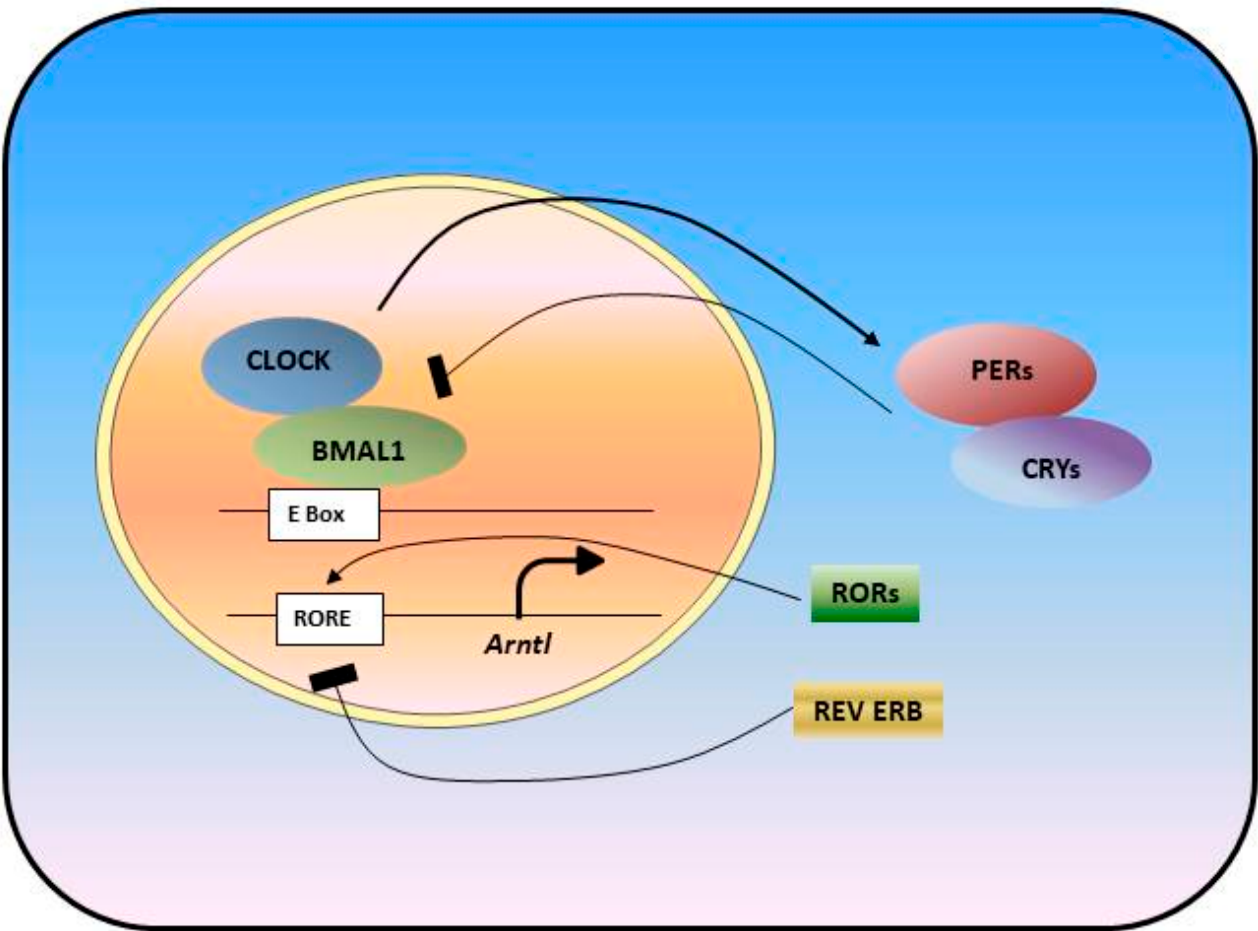
Figure 1. Molecular Circadian Oscillator is formed as a transcriptional translational feedback loop. Transcription factors, BMAL1 and CLOCK, drive the transcription of clock genes: Pers, Crys, Rev-Erbs, Rors. PER and CRY proteins, in turn, heterodimerize and inhibit CLOCK/BMAL1 complex activity and their own transcription, which form one loop. Rev-Erbs and RORs form a second loop and act by either repressing or activating Bmal1 transcription.